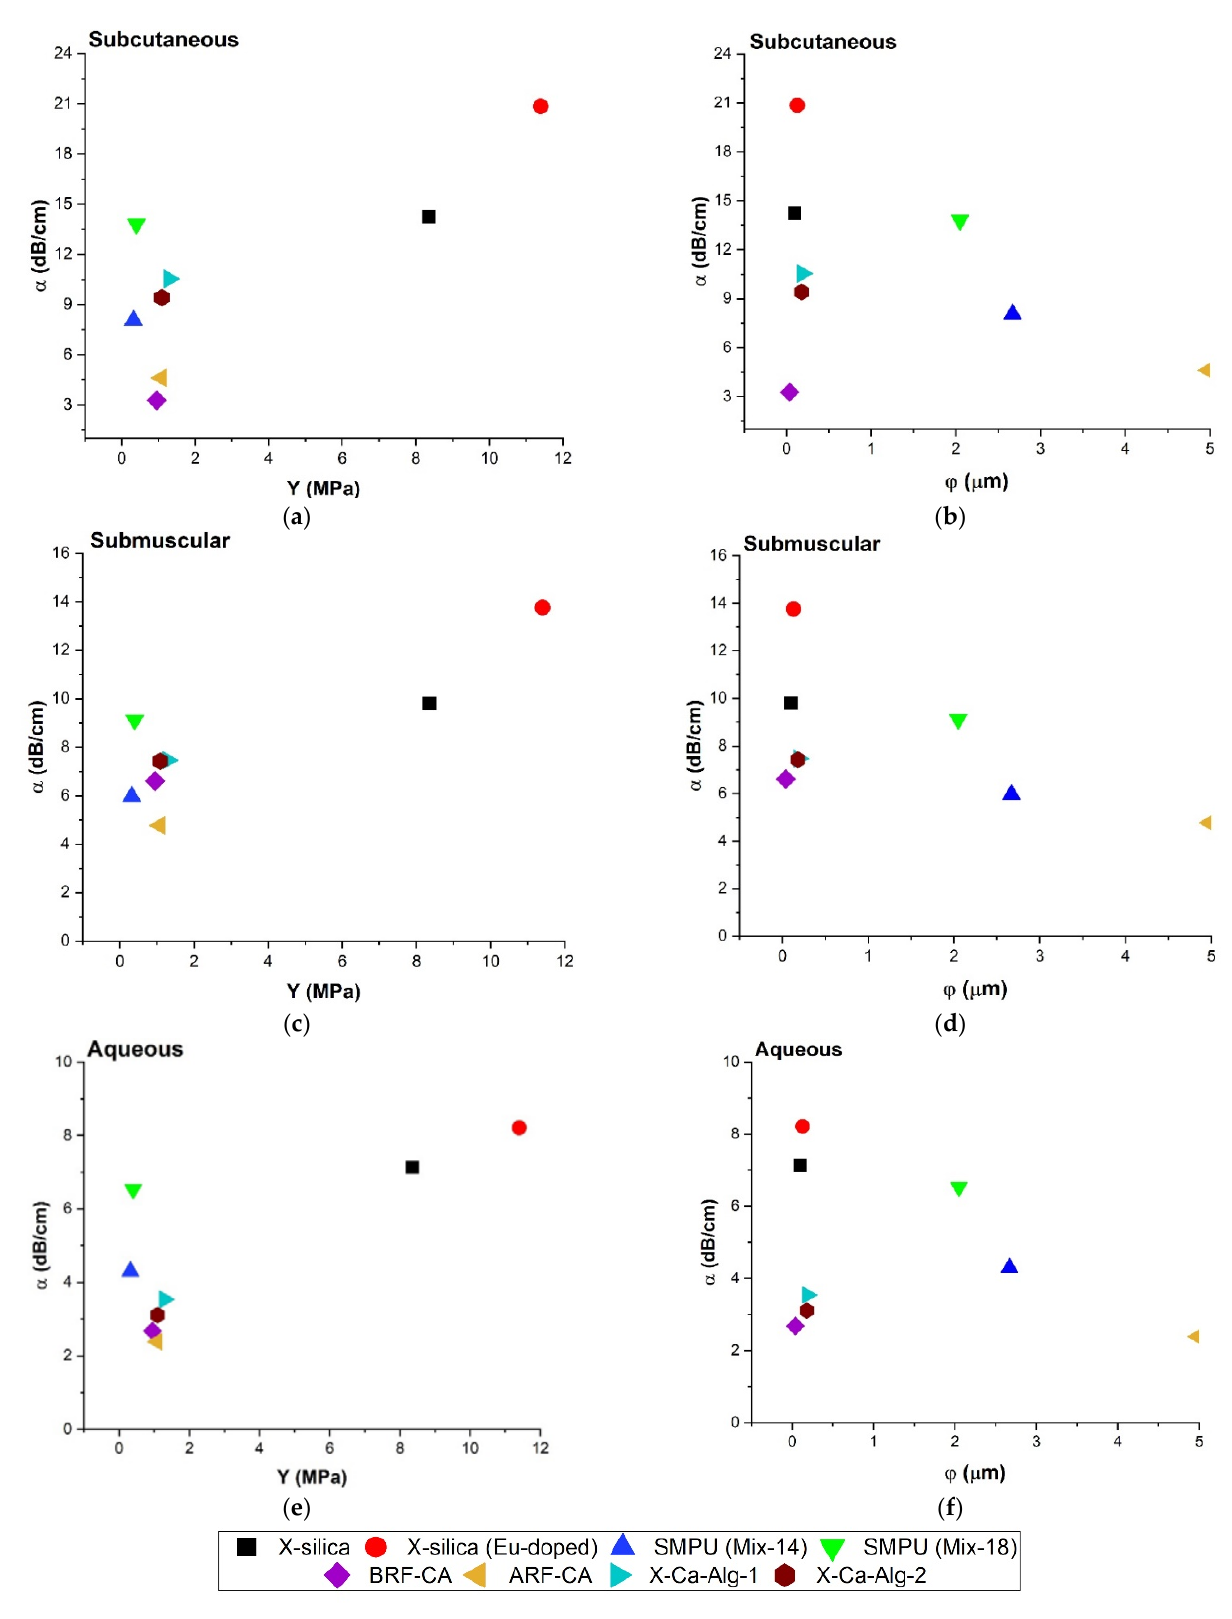
Figure 7. Comparison of attenuation coefficient ( α ) at 8.5 MHz, Young’s modulus (Y), and Pore diameter ( φ ) for all three configurations; Aq environment samples inserted SC and SM measured at a scan frequency of 8.5 MHz. ( a ) α vs Y in SC region, ( b ) α vs φ in SC region, ( c ) α vs Y in SM region, and ( d ) α vs φ in SM region. ( e , f ) represent α vs Y and α vs φ respectively in an Aq environment.